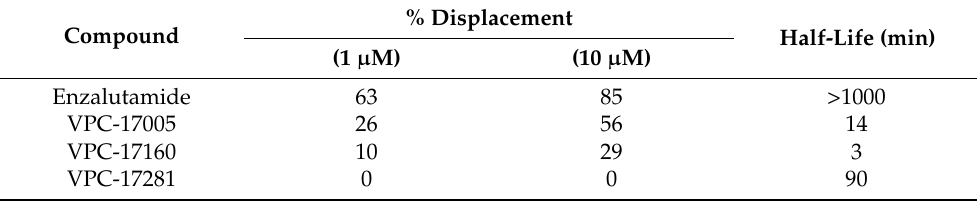
Table 1. Androgen displacement at the ligand-binding site and microsomal